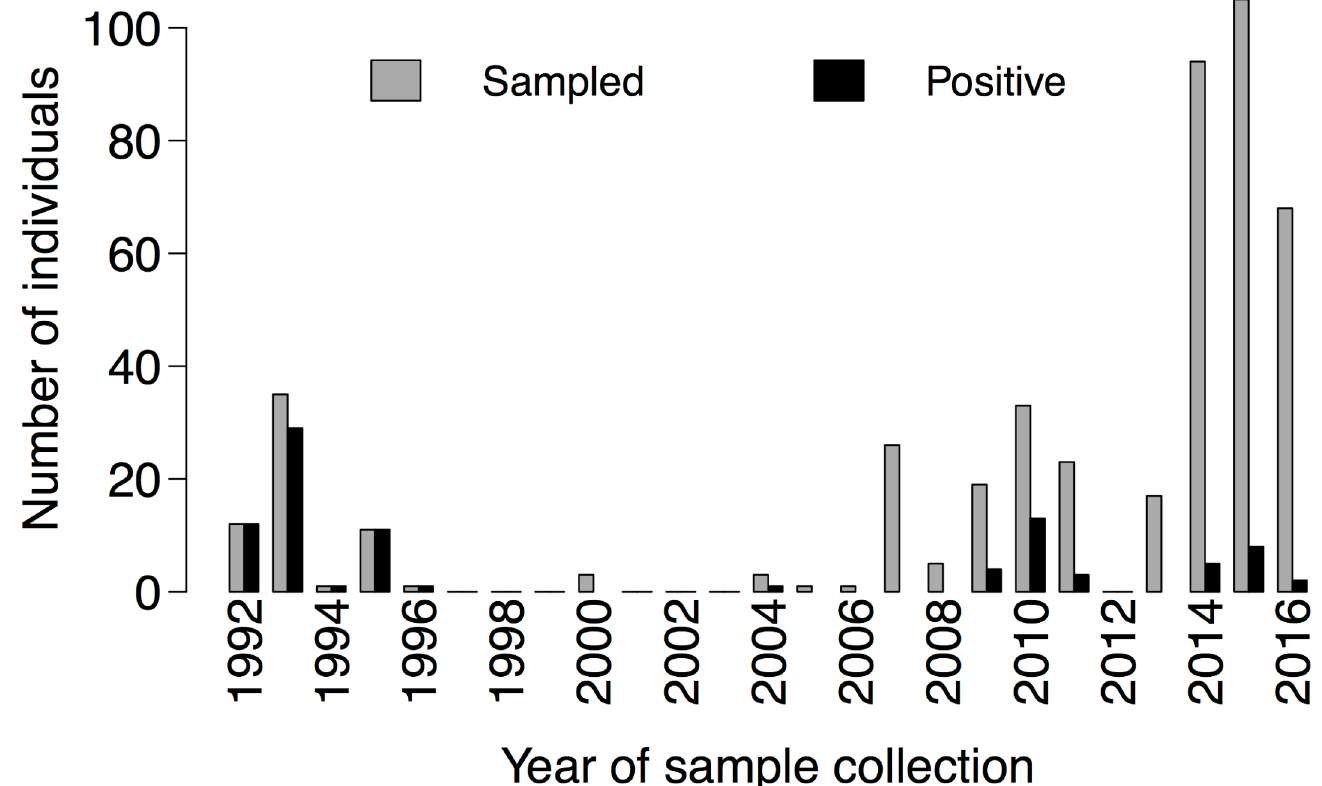
Fig 1. Temporal distribution of ranavirustesting and detection in amphibians and reptiles of the British Isles.